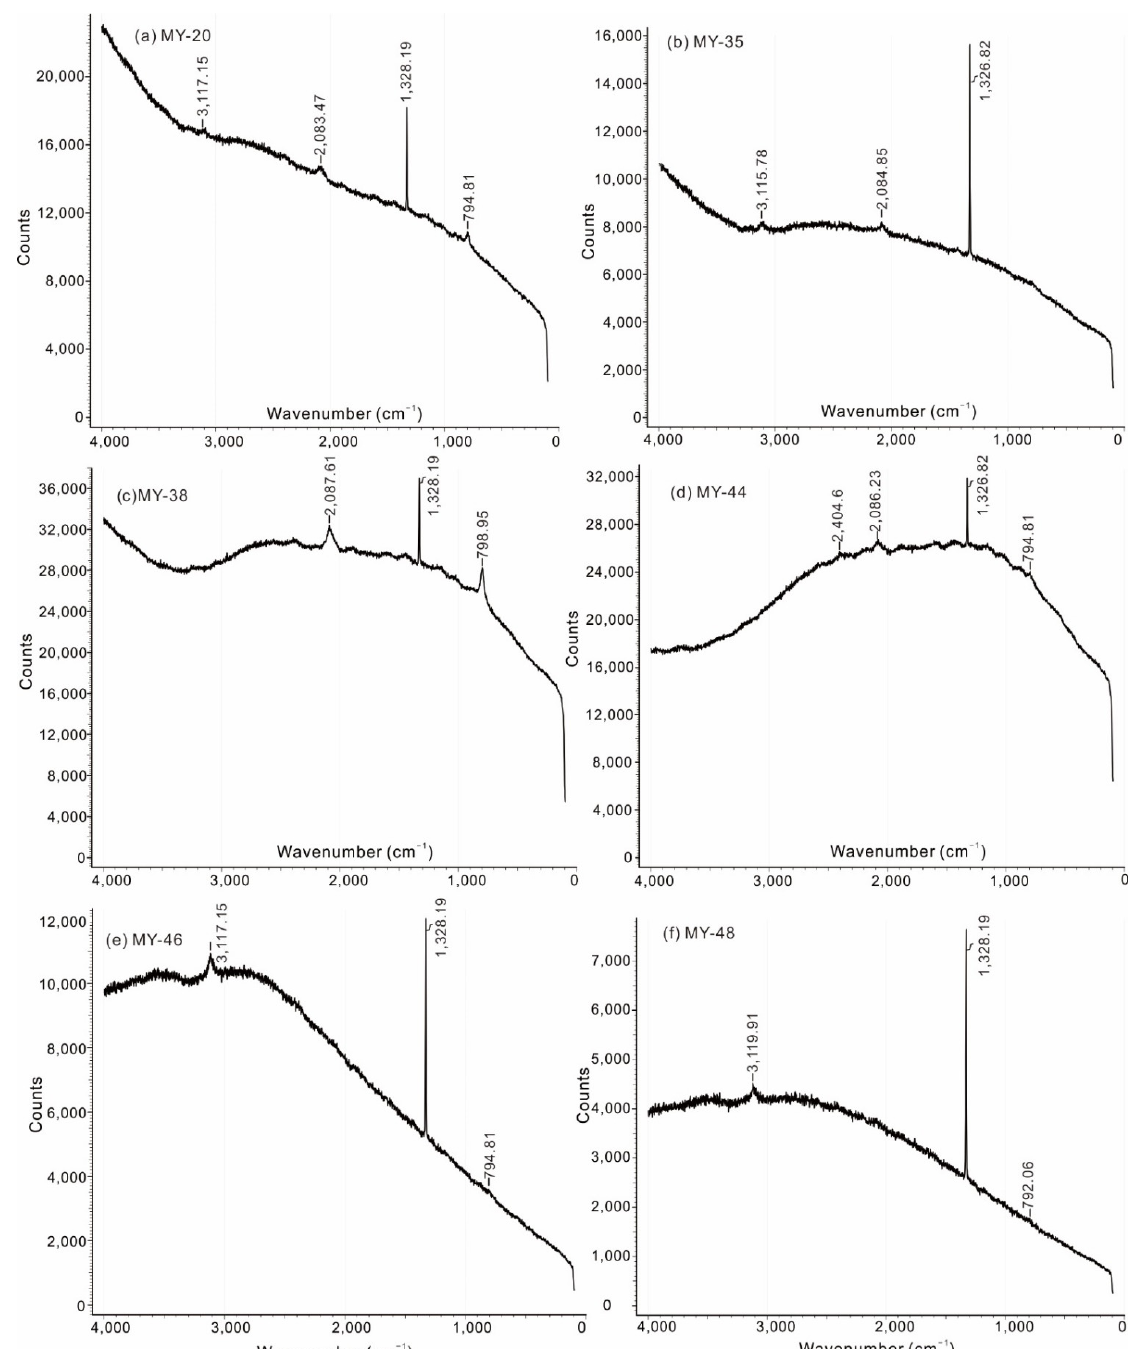
Figure 6. Raman Spectra of representative brown diamonds from the Mengyin deposit.